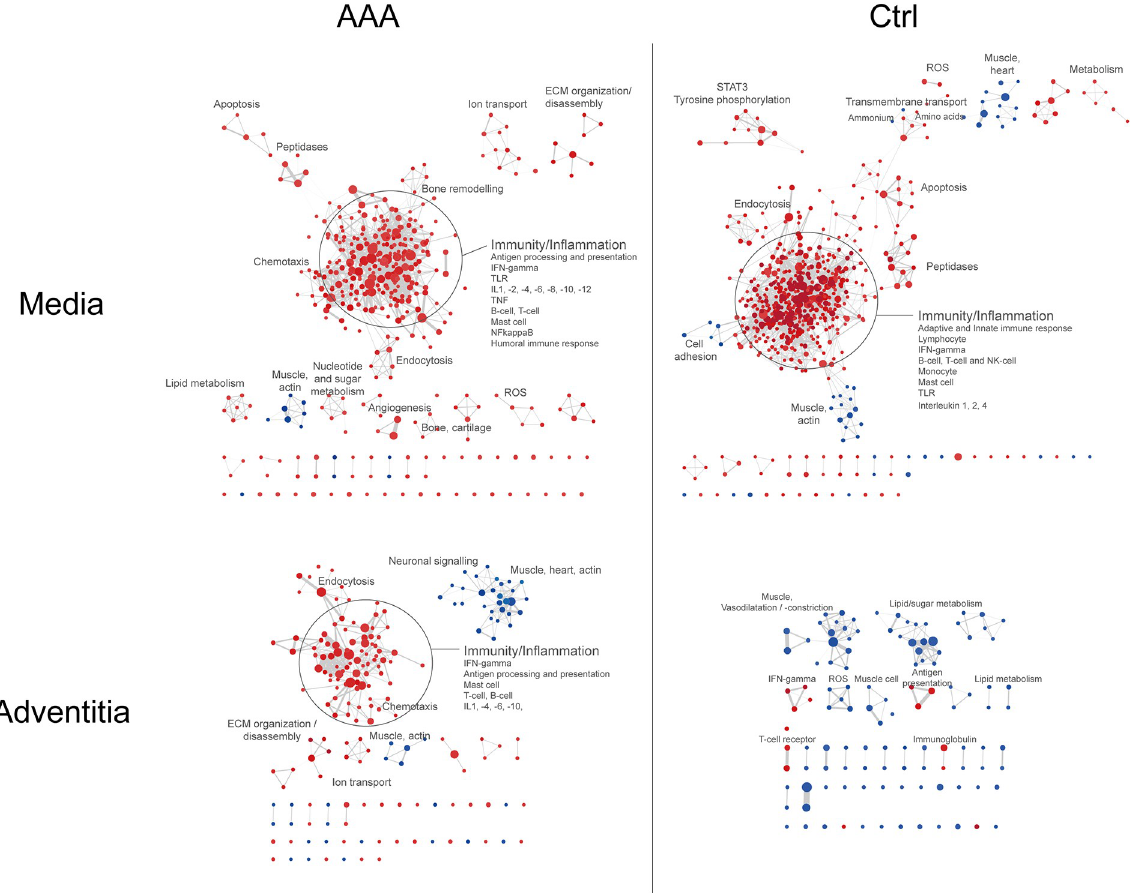
Fig 4. Gene set enrichment analysis of genes co-expressed with DPP4. Genes were ranked according to association with DPP4 expression, as calculated by the limma package in R, and input into GSEA. Networks of enriched biological processes were created in Cytoscape. Each node represents a significantly enriched biological process, where red color represents upregulation, blue color downregulation and the point size corresponds to the number of genes included into the set. Edges correspond to the number of genes in common between two nodes, normalized against the size of the smallest gene set. Abbreviations; ECM: extracellular matrix, ROS: reactive oxygen species.